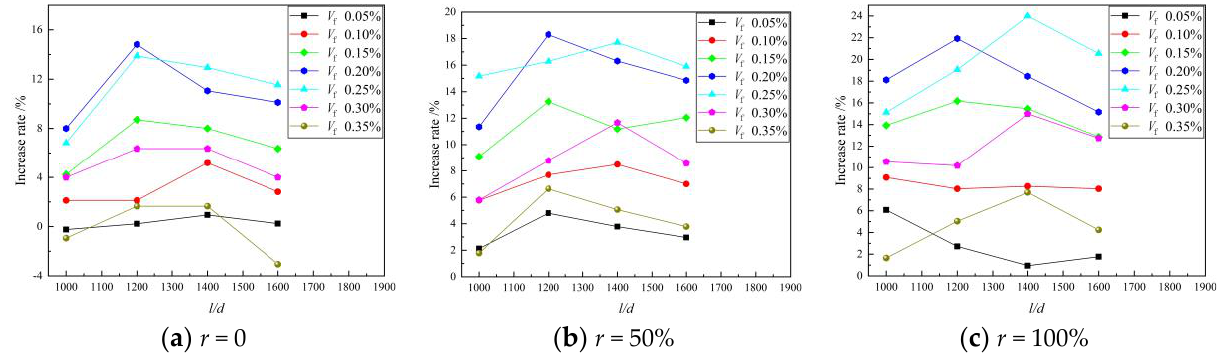
Figure 6. Relation between BFRAC cube compressive strength and BF length – diameter ratio. ment rate of 100%, when the fiber volume fraction of BFRAC was less than 0.15%,